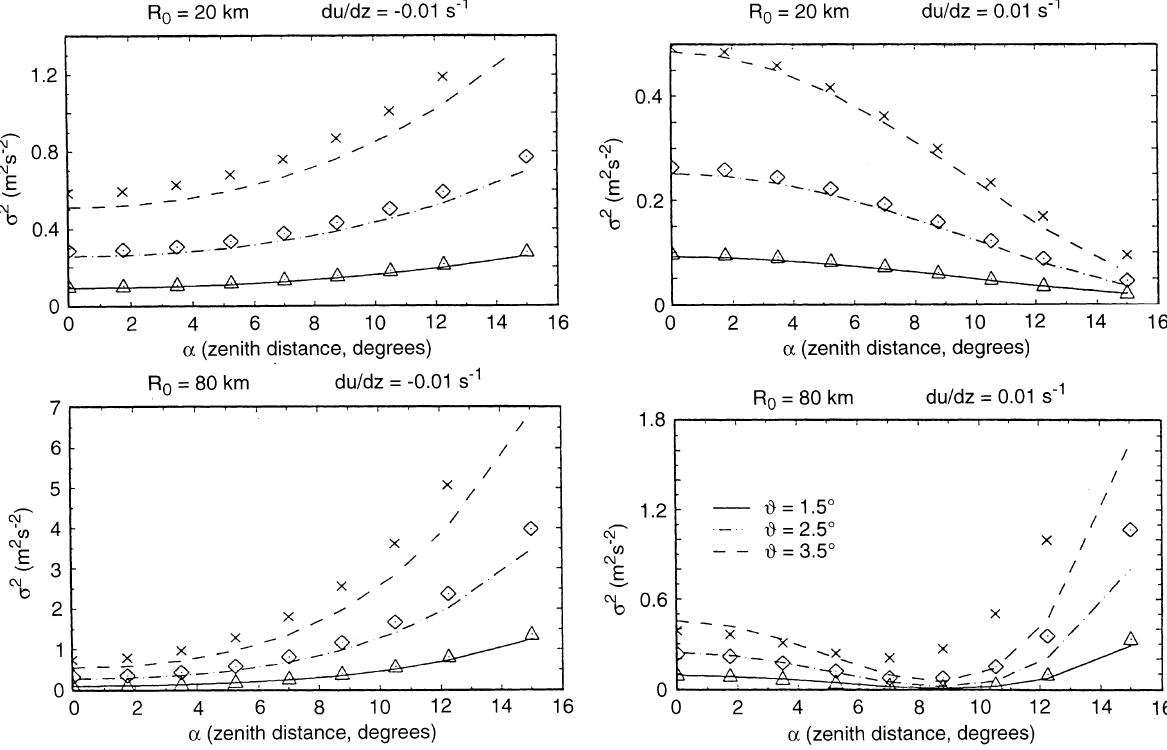
Fig. 5. As in Fig. 3, except for solutions as a function of zenith distance for typical half-beamwidths